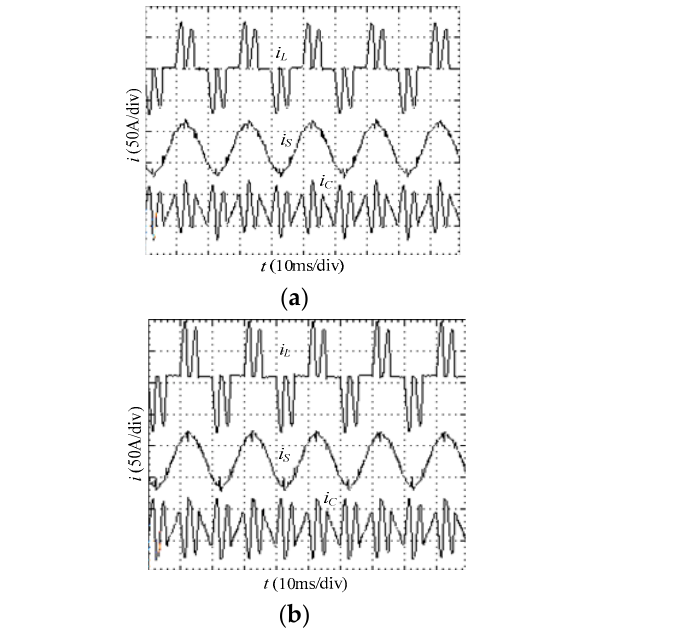
Figure 14. Experimental waveforms. ( a ) Series inductance 100 μ H. ( b ) Series inductance 250 μ H.